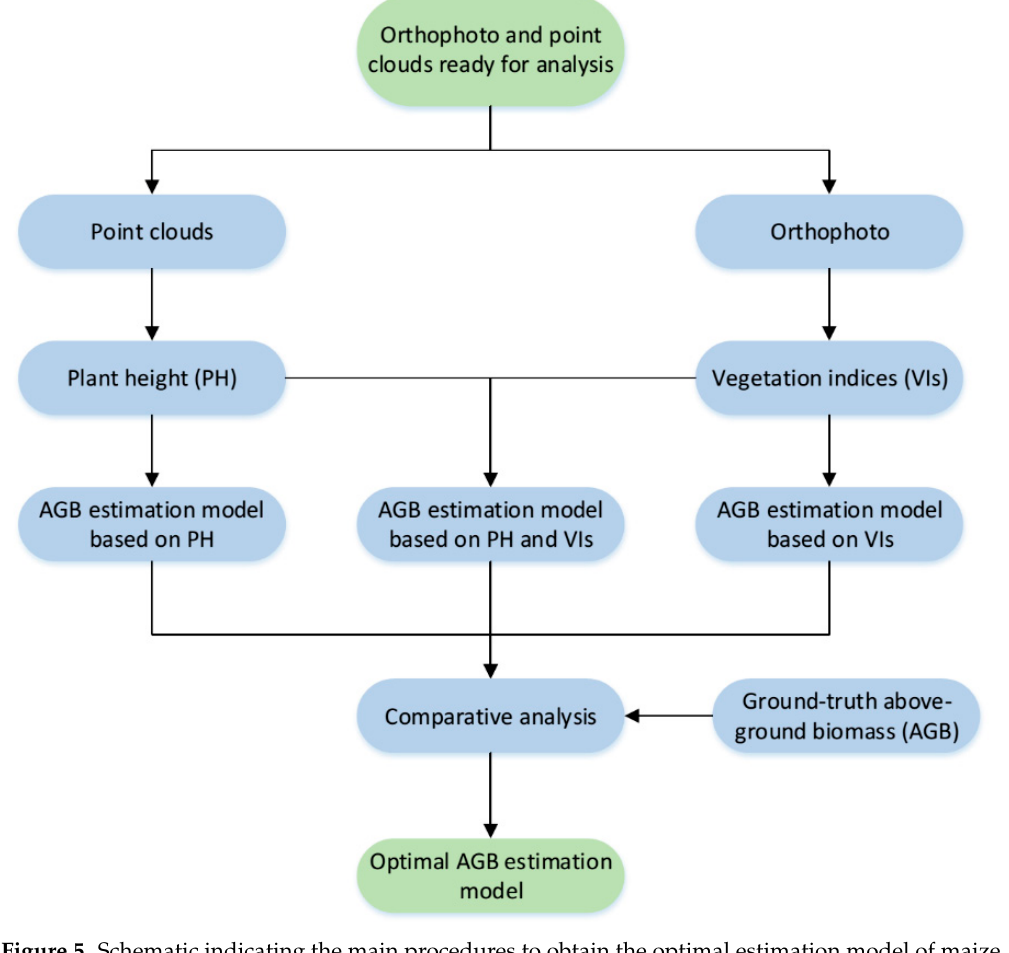
Figure 5. Schematic indicating the main procedures to obtain the optimal estimation model of maize above-ground biomass (AGB) based on features derived from UAV RGB imagery.